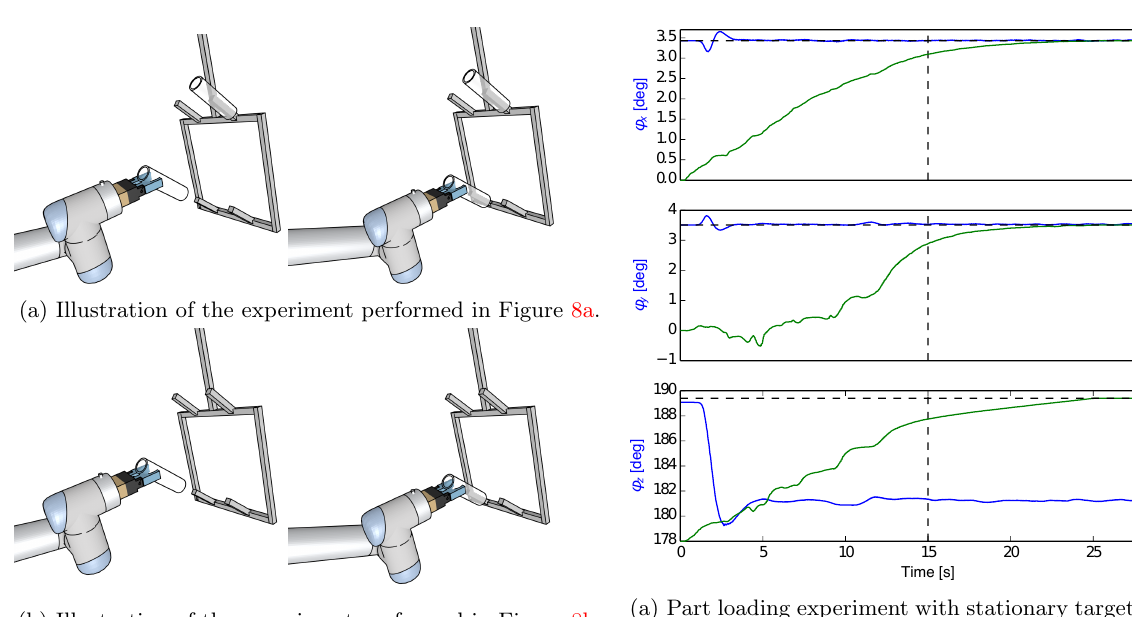
ditional load was placed on the upper right loading po- sition in order to shift the center of mass as shown in Figure 7: The same experiment is performed twice, Figure 7a. first with a heavy load, then without a heavy load. During the experiment the end-effector moves from the pose on the left ( T B ), to the 1 pose on the right ( T B ) and finally back (to 2 ). T B 1